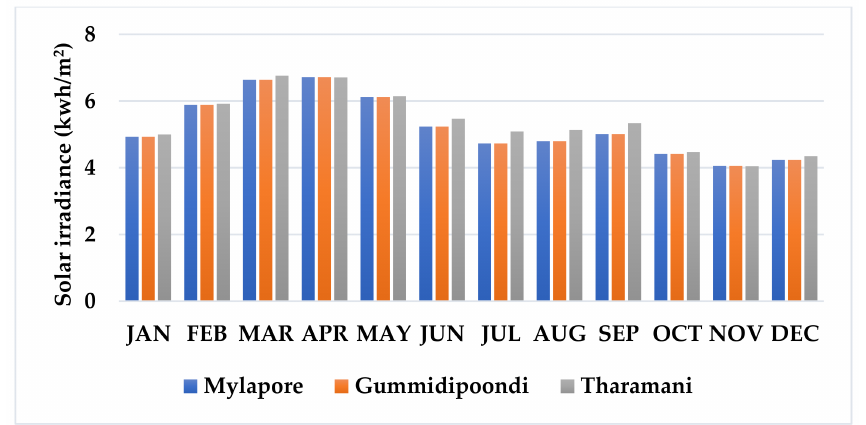
Figure 14. Annual solar irradiance at selected locations (kwh/m 2 ).